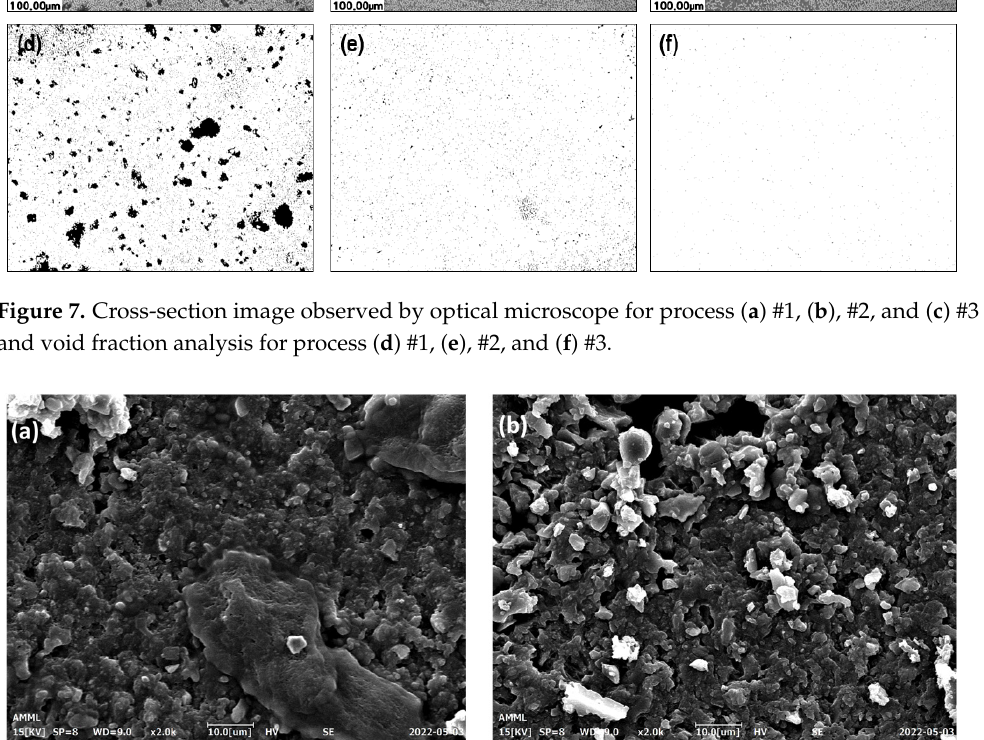
Figure 8. Cross-section image observed by scanning electron microscope for processes ( a ) #2 and ( b ) #3.